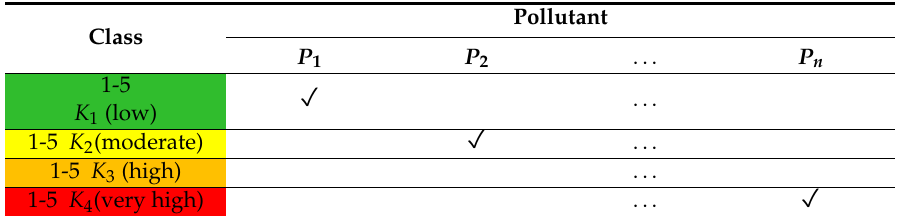
Table 3. Distribution of pollutants by class .